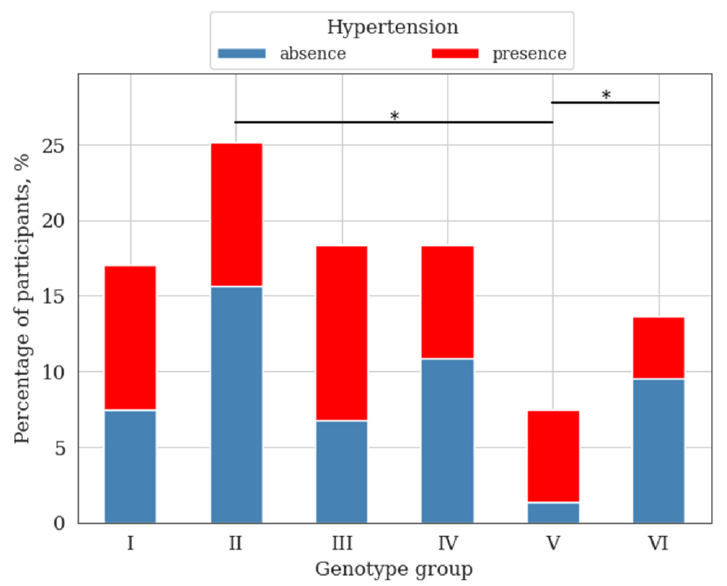
Figure 7. The presence of hypertension among the studied groups, depending on clusters; *—differences were considered significant at a corrected p -value ( p ) < 0.05 ( χ 2 test, post-hoc pairwise χ 2 test Benjamini–Hochberg FDR correction).